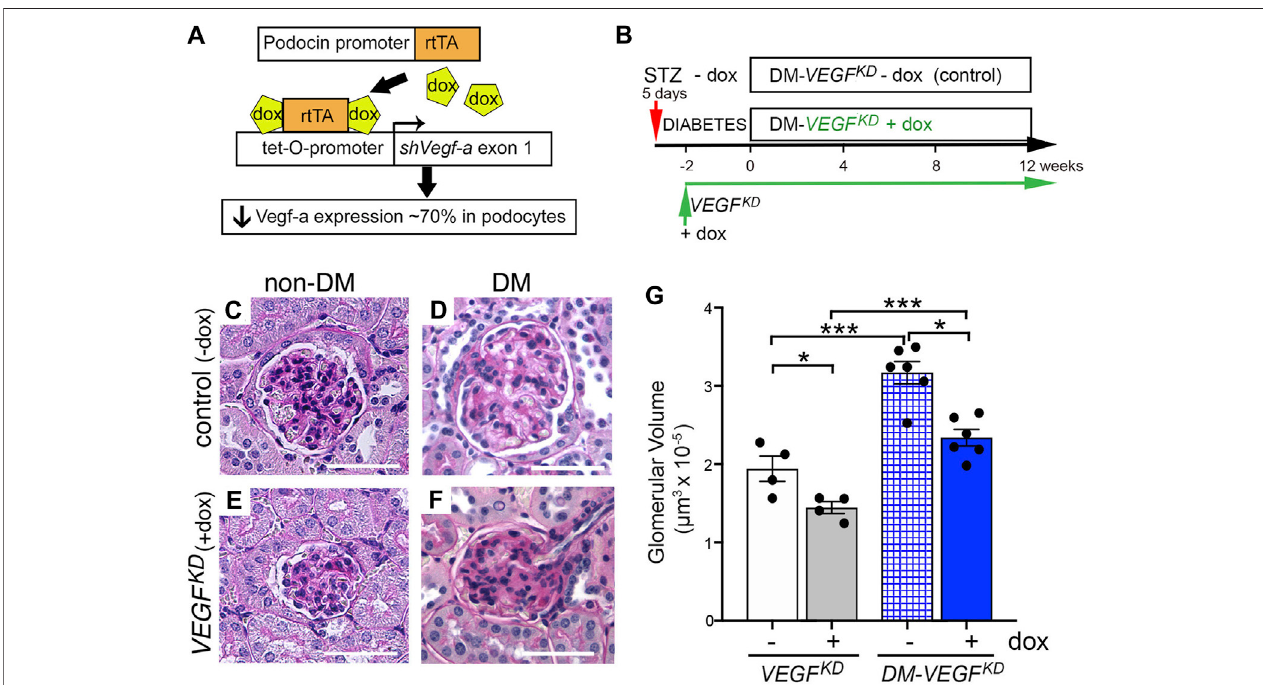
FIGURE 1 | Podocyte VEGF knockdown( VEGF KD )preventsglomerularhypertrophyindiabeticmice. (A) VEGF KD Transgenicmouselinecarries4transgenes: Nphs2-rtTA and tet-0-shVEGF thatareactivatedbydoxycyclinetosynthesizeshRNAtargeting Vegf-a exon1,whichinhibitsexpressionofall Vegf-a isoformsinpodocytes(Veronetal.,2012). (B) VEGF KD mice received STZ (50 mg IP, 5 daily doses) (DM- VEGF KD − dox), STZ + doxycycline (DM- VEGF KD + dox), doxycycline ( VEGF KD + dox) or no treatment ( VEGF KD − dox).DoxwasstartedaweekafterSTZ,2 weekslaterwasconsideredtime0(whenrandombloodglucosewassteadilyelevated)forDM- VEGF KD mice; (C) non-diabeticcontrolglomerulus( VEGF KD − dox)showsnormalhistology; (D) diabeticcontrol(DM- VEGF KD − dox)glomerulusshowshypertrophyandmesangialexpansion; (E) non-diabetic VEGF KD (+ dox) glomerulus is smaller than control (C, − dox); (F) diabetic VEGF KD (+ dox) glomerulus shows diffuse glomerulosclerosis and is smaller than control(D, − dox);Scalebars=50 μ m; (G) quantitationofglomerularsizedemonstratessigni fi cantlysmallerglomerularvolumein VEGF KD (+dox)vs.control( − dox)glomeruli fromnon-diabetic( VEGF KD )anddiabetic(DM- VEGF KD )mice;unpaired t -testwithWelch ’ scorrectionwasused;asterisk(*)indicates p < 0.05,(***)indicates p < 0.001;control vs. VEGF KD or non-diabetic vs. diabetic, as indicated; non-DM, non-diabetic mice, DM, diabetic mice; dox, uninduced mice; dox, doxycycline- treated